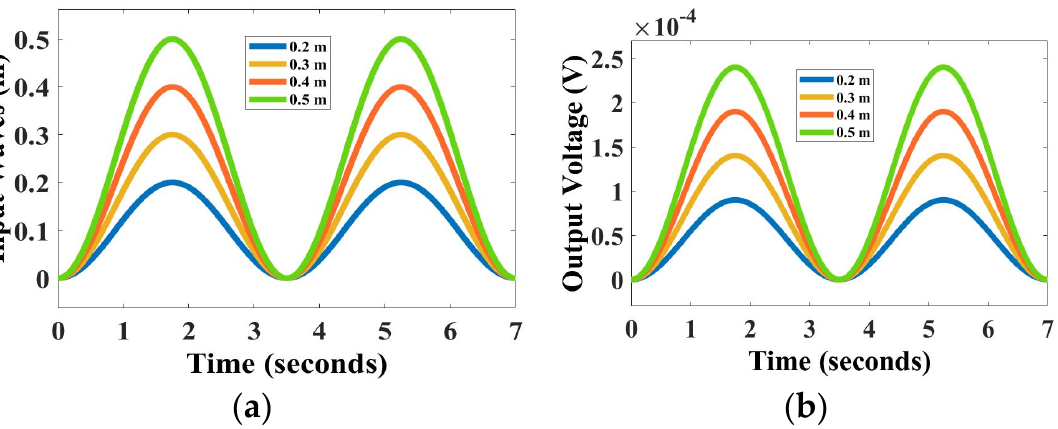
Figure 6. Input waves and output voltages: ( a ) Input ocean waves of height from 0.2 to 0.5 m; ( b ) Output voltages for ocean waves of 0.2 m (Blue line), 0.3 m (Orange line), 0.4 m (Red line), and 0.5 m (Green line) height.